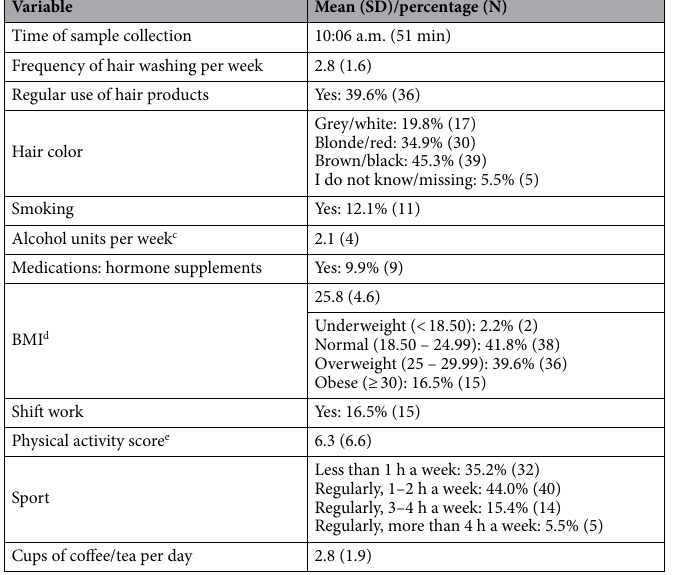
Table 2. Sample characteristics (N = 91). BMI Body-Mass-Index; HADS Hospital Anxiety and Depression Scale; PDS Posttraumatic Diagnostic Scale; PSQ‑20 Perceived Stress Questionnaire (20 item version); SF‑ 12 Short Form-12 Health Survey; SOMS Screening of Somatoform Disorders; STAI State-Trait Anxiety Inventory (State Anxiety); TQ Tinnitus Questionnaire. a Education levels: low = elementary, secondary, or middle school; medium = high school or completed apprenticeship; high = university. b Mean hearing threshold across all measured frequencies. Grading of hearing thresholds: 50 . c Alcohol units consumed per week: one unit = 0.3 l beer or 0.2 l wine or shot glass of spirits. d BMI classification: 52 . e Physical activity score: number